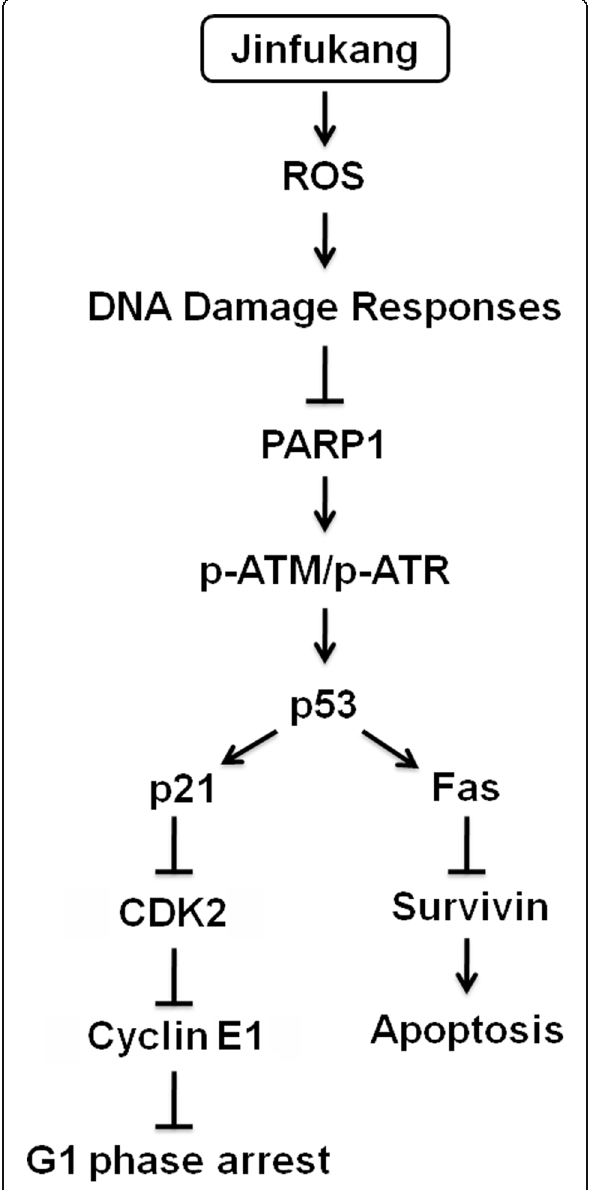
Fig. 5 A pattern diagram of Jinfukang-induced apoptosis in lung